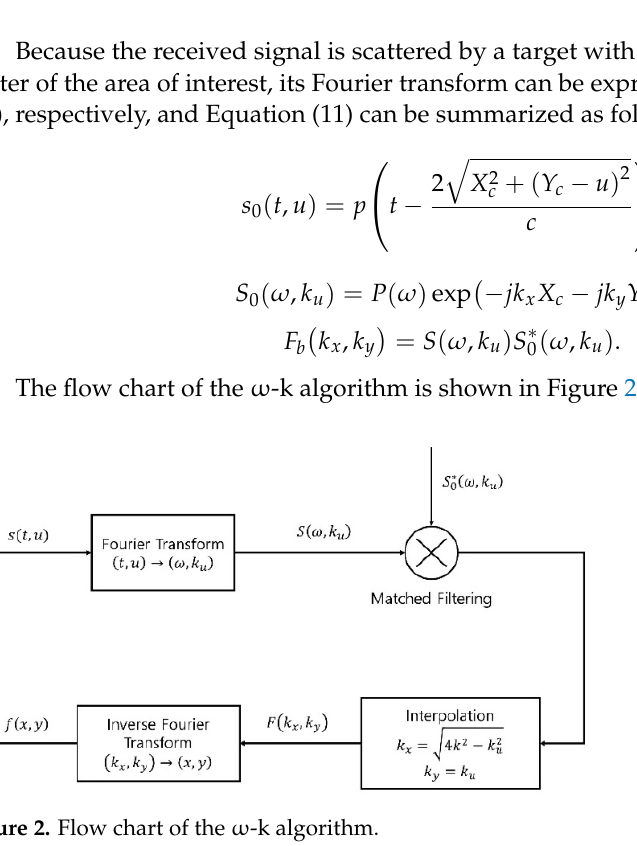
Figure 2. Flow chart of the ω -k algorithm.